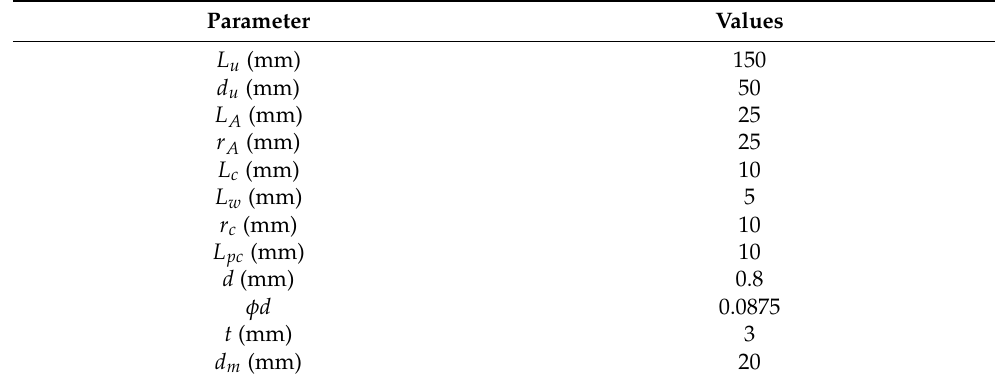
Table 2. Geometric parameters of the hybrid sound-absorbing metastructure in finite-element simulations.